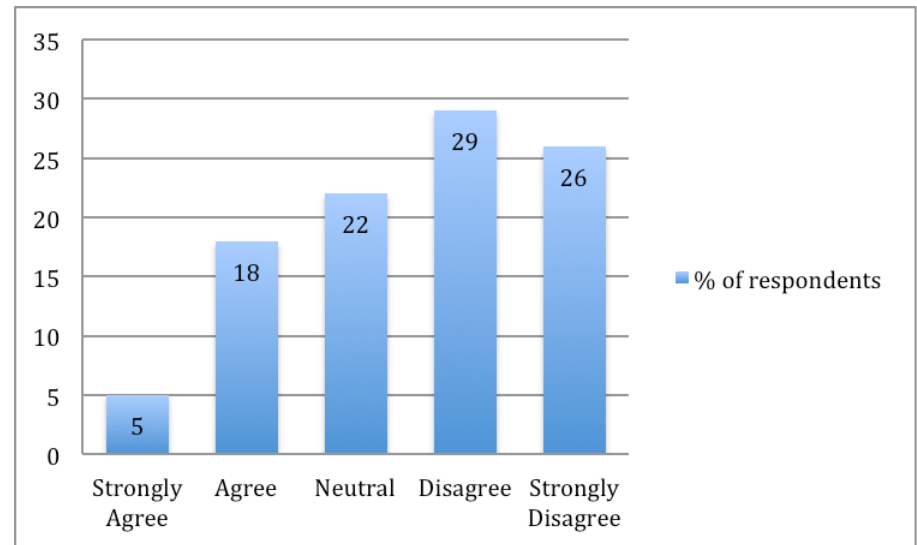
Figure 3. Lack of time to find suitable